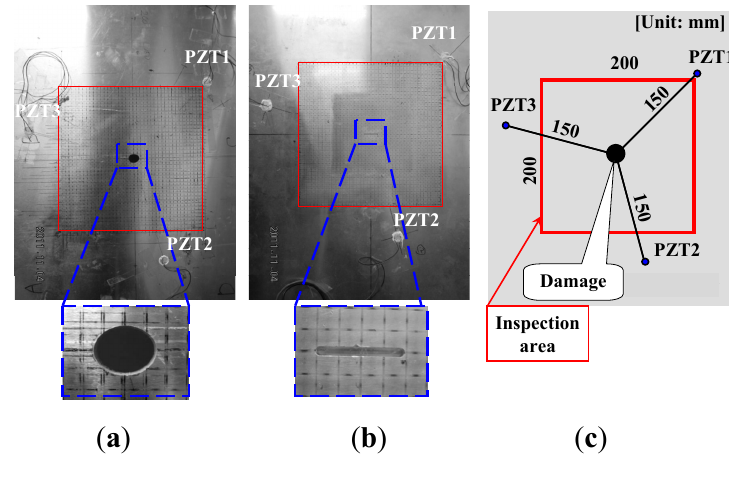
Figure 2. An aluminum plate: ( a ) with an elliptical through-hole; ( b ) with a non-penetrating slit; ( c ) position of sensors and